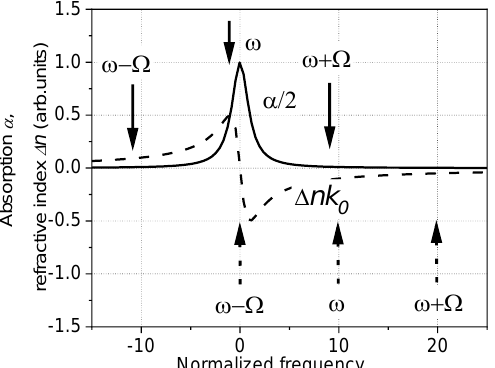
Figure 3. Position of the laser carrier frequency and the modulation sidebands in the acetylene absorption profile (solid line presents the gas amplitude absorption α /2, while the dashed line presents the refractive index ∆ nk 0 ) for two utilized demodulation modes. Solid arrows correspond to the wideband demodulation and dashed arrows to the narrowband demodulation. The experimentally observed frequency response of this demodulation mode (i.e., the frequency dependence of the phase-to-amplitude transfer function) is presented in Figure 4a by curve 1. This dependence was obtained in the OEO open-loop configuration with the sinusoidal modulation signal of 0 dBm, applied to the electrooptic phase modulator, and for the incident laser power of 5 mW.